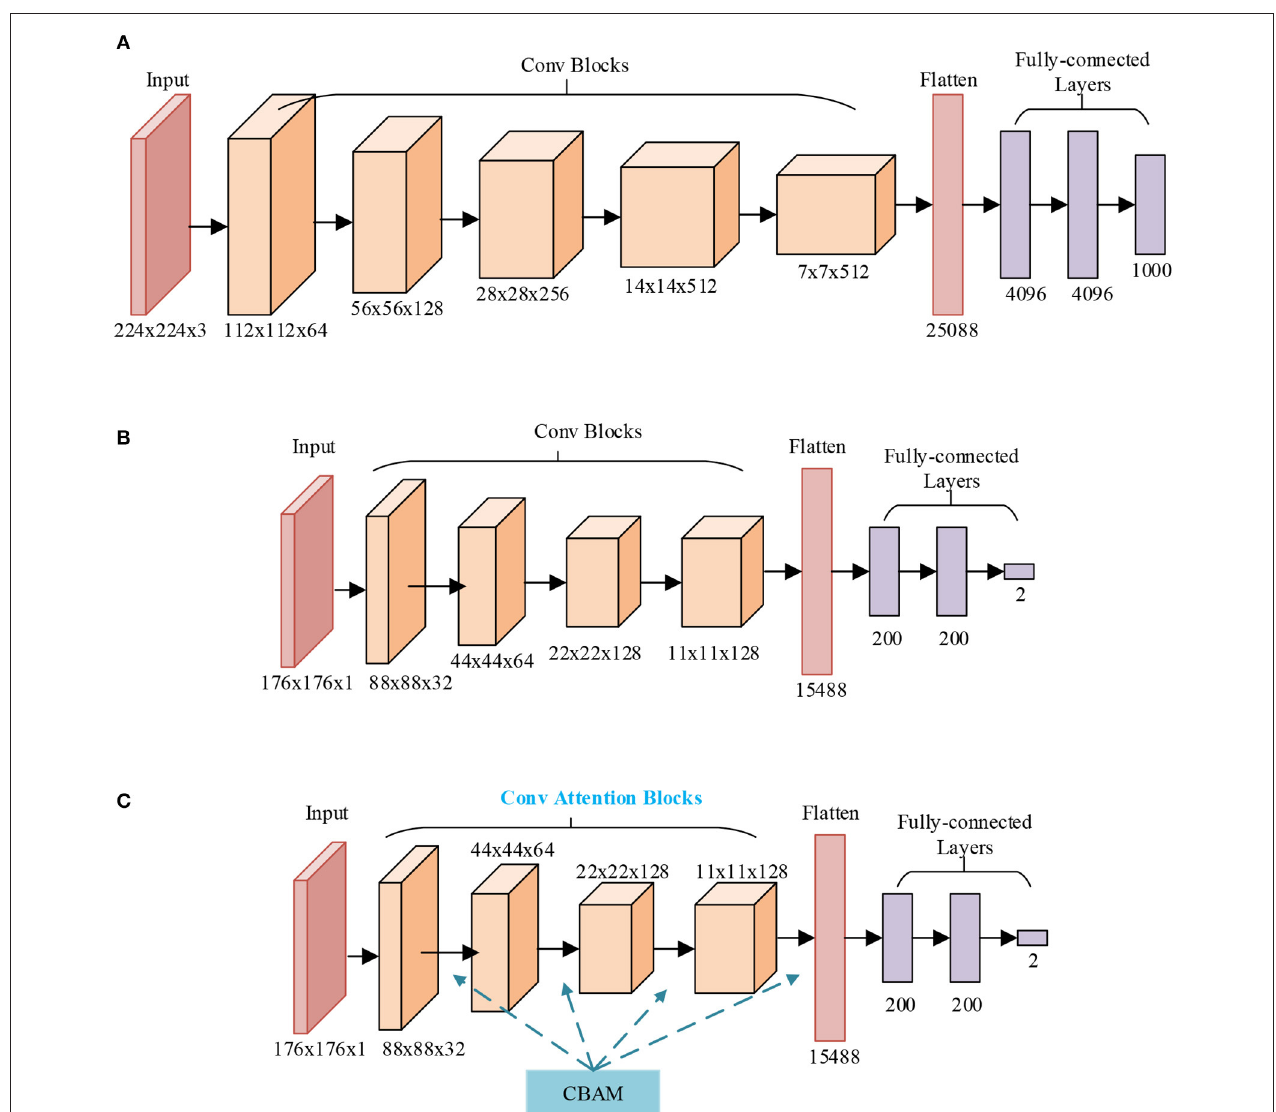
FIGURE 5 | Structures of three networks. (A) VGG-16, (B) VIN (Ours), (C) ADVIAN (Ours).